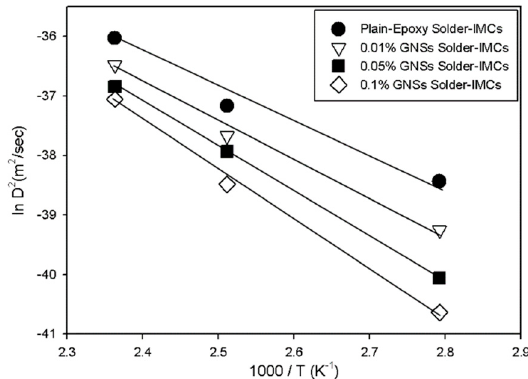
Figure 6. Arrhenius plot of the IMC layer for the four solder types.